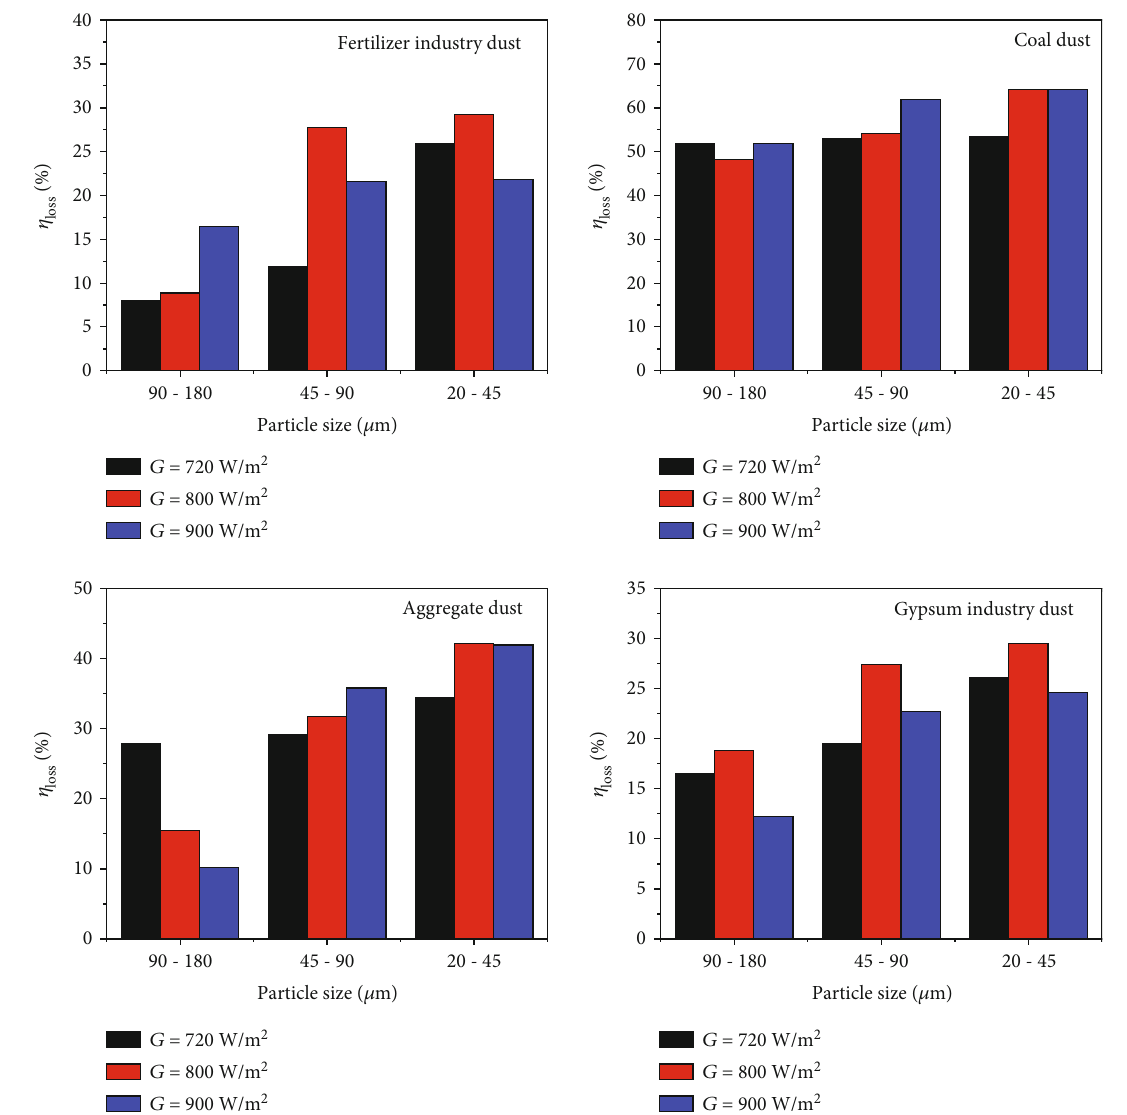
Figure 10: Performance e ffi ciency loss for the four tested dust